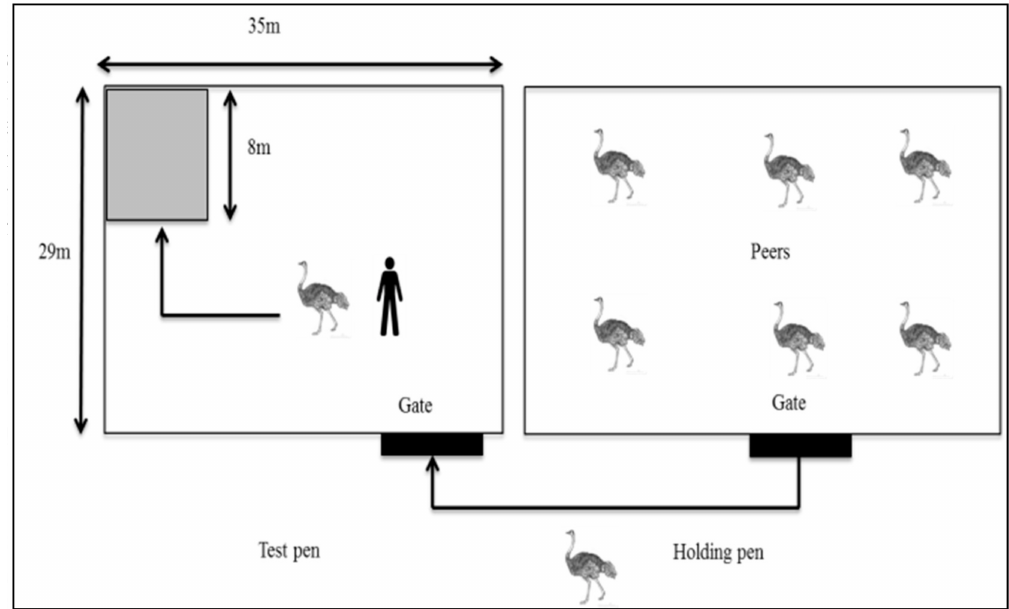
Figure 1. Experimental procedure used during the docility test showing the holding pen (with peers) and the test pen (with a marked square drawn on the corner opposite the gate). One bird was taken from the holding pen to the test pen and encouraged to enter the marked square and remain contained there for 30 s by either a familiar or an unfamiliar